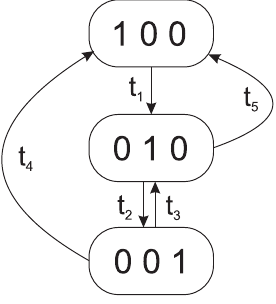
Figure 11. Reachability